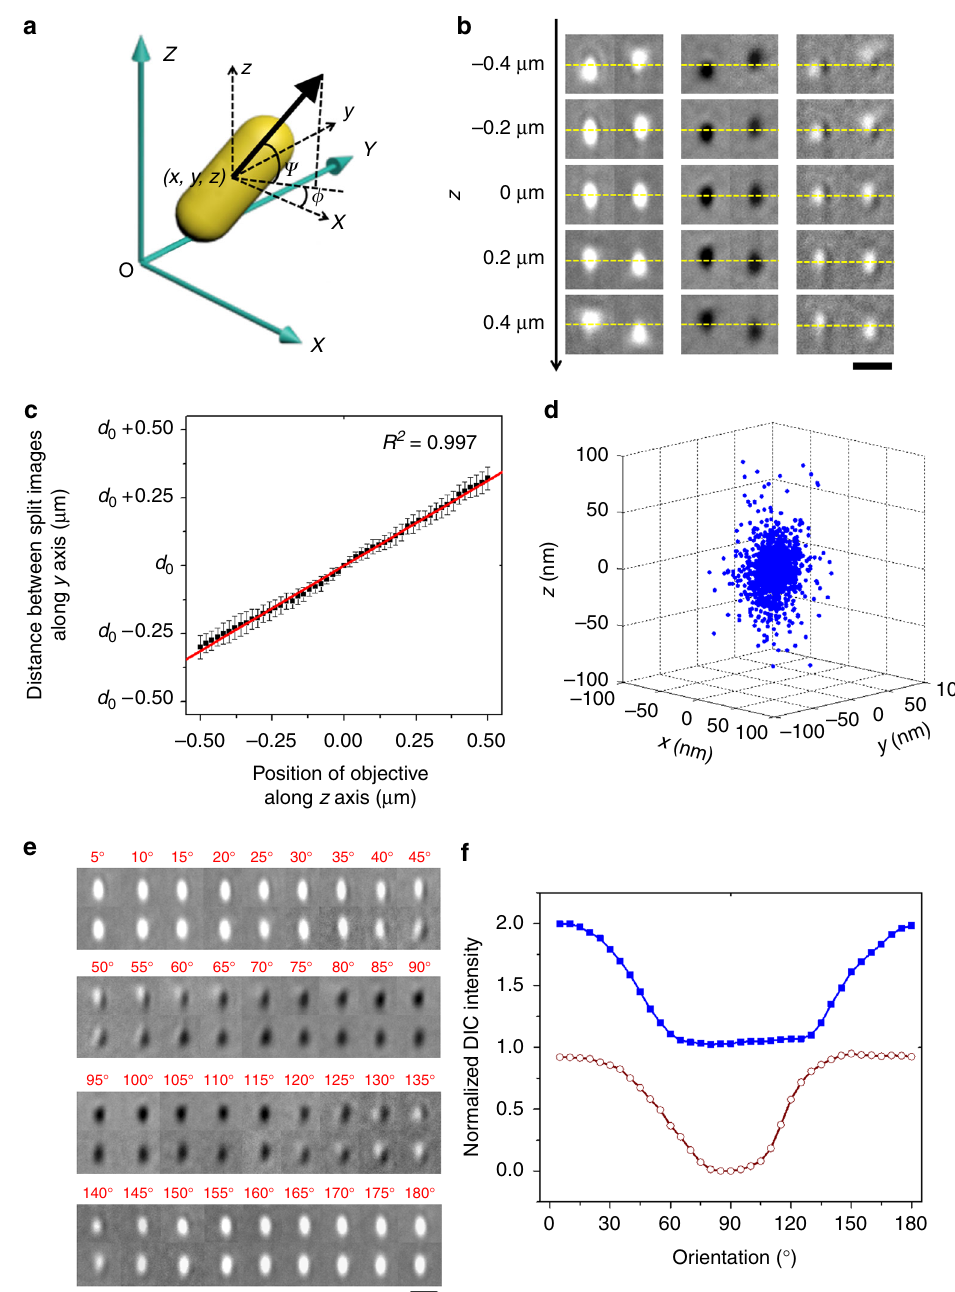
Fig. 1 Principle and localization precision of the parallax-DIC microscope. a Schematic illustration of a gold nanorod placed in the 3D coordinate system. The x - and y -axes are set according to the polarization directions of the illumination light. The dipole shown here corresponds to the long axis of the gold nanorod, whose centroid locates at ( x , y , z ). The azimuthal angle and the elevation angle of the longitudinal axis of the gold nanorod are presented as ϕ and ψ , respectively. b Bright (left), dark (middle), and half-bright/half-dark (right) images of a gold nanorod (40 × 80 nm) at different orientations and vertical positions. The half-plane images are aligned by the nanorod ’ s center of mass at the focal plane ( z = 0 μ m). The yellow dashed lines indicate the z -position of the center of the gold nanorod in focus. Scale bar is 1 μ m. c Calibration of the 5D-SPT technique. The distance between the two half-plane images changes linearly with the z -position of the gold nanorod within ± 0.5 μ m of the focal plane. The distance for an in-focus gold nanorod is de fi ned as d 0 . The error bars re fl ect the standard deviations of the distances measured when the nanorod ’ s azimuthal angle ϕ changes in the range of 0 – 180° with 5° steps (error bar ± s.d., n = 36). The calibration curve returned a slope of +0.626 ( d / Δ z ) and R 2 of 0.997. d Three-dimensional localization distribution of the gold nanorod with standard deviations of 11 nm in x , 14 nm in y , and 17 nm in z . e The in-focus half-plane image patterns of a gold nanorod at different azimuthal angles when the sample slide is rotated in 5° steps for 180°. The scale bar represents 1 μ m. f The normalized bright part (blue) and dark part (brown) intensities of the half-plane images on the top in each pair in